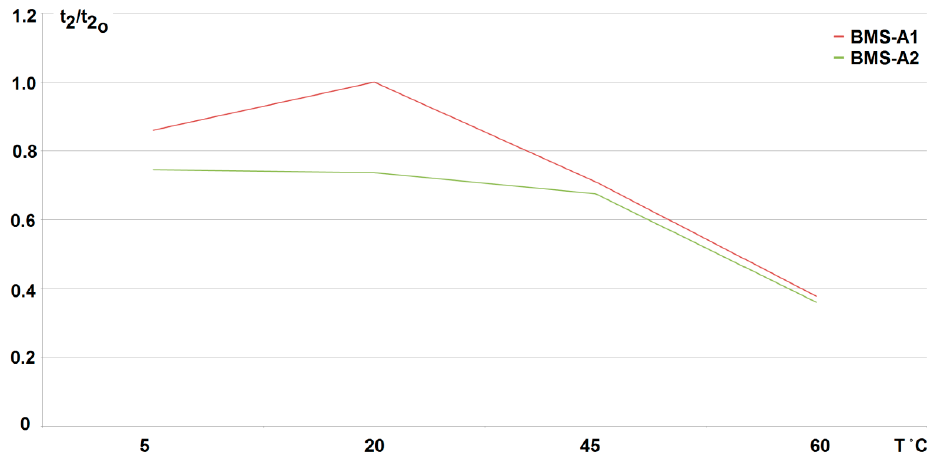
Figure 19. Variation in fading time t 2 of cell voltage to its minimum value (U = 2.5 V) with ambient temperature T when use active BMS (BMS-A1-battery to cell method, BMS-A2-cell to battery); reference time for 20 °C equal t 20 = 114 min for BMS-A1).